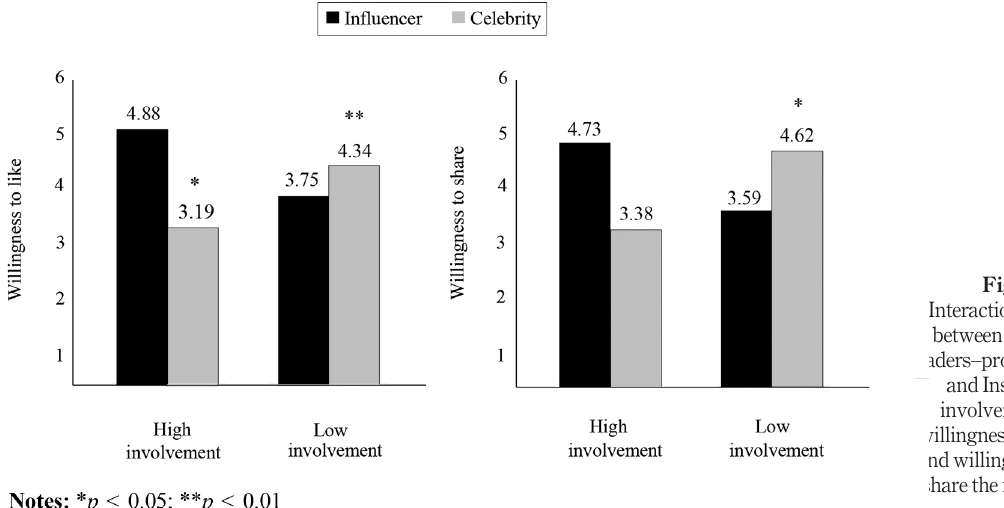
Figure 3. Interaction effect between opinion leaders – product fi t and Instagram involvement on willingness to like and willingness to share the fi t